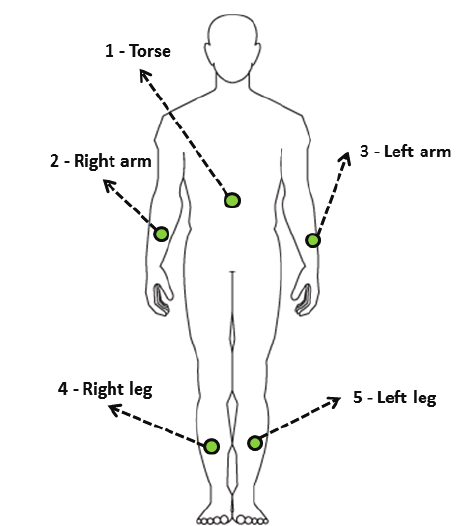
Figure 4. Location of the five wearable IMUs used in the dataset.